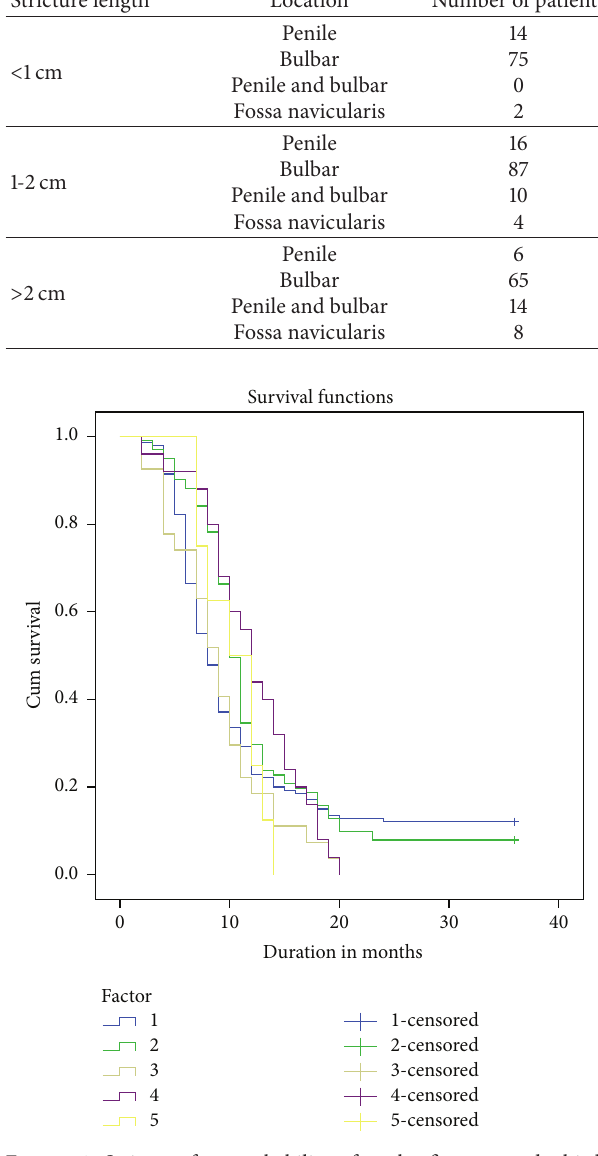
Figure 1: Stricture-free probability after the first, second, third, fourth, and fifth urethrotomies (Kaplan-Meier survival